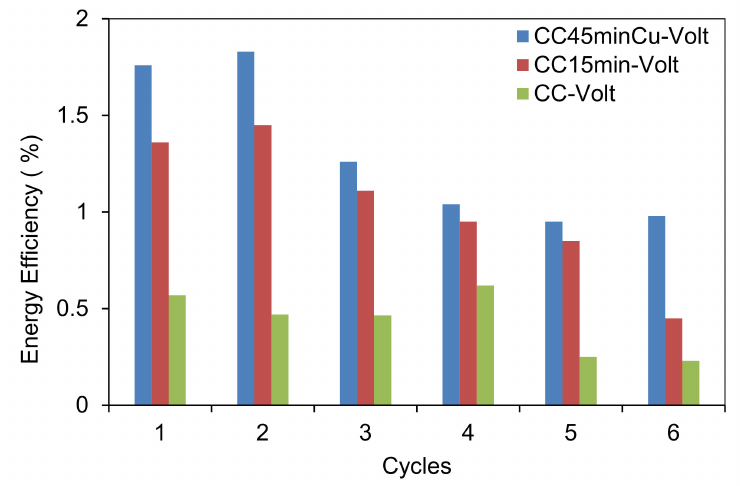
Figure 9. Energy Efficiency for serum bottles CC-volts, CC15min-volts and CC45minCu-volts over the 6